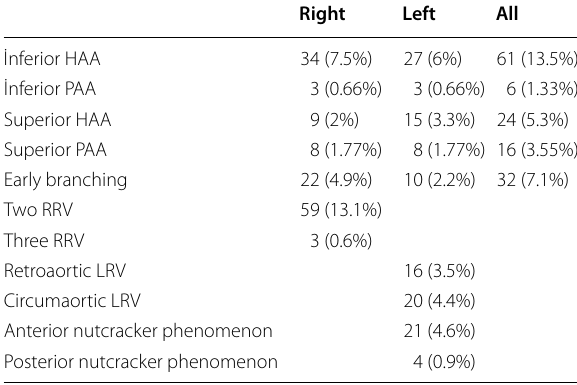
* HAA hilar accessory artery, PAA polar accessory artery, RRV right renal vein, LRV left renal